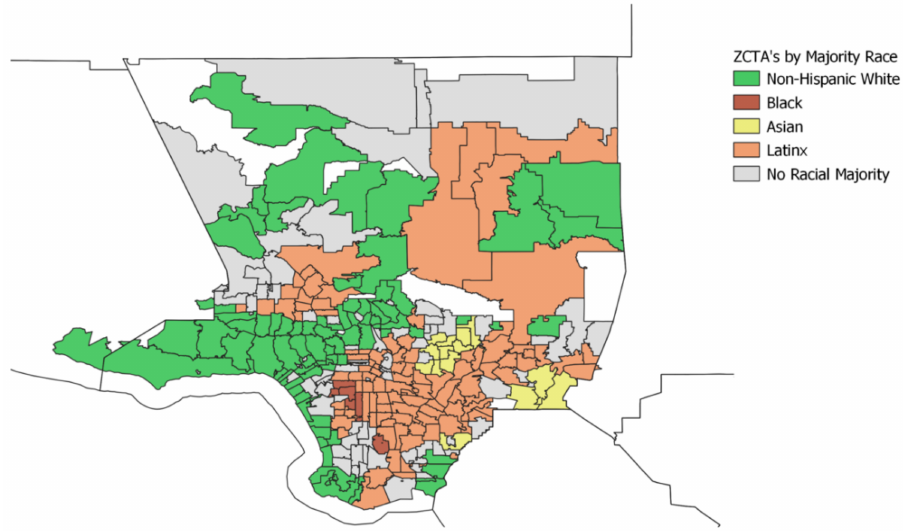
Figure 10. ZCTAs in Los Angeles County by Majority Ethnoracial Group. Figure 10 identifies the majority ethnoracial group in each zip code tabulation area (ZCTA) as determined by the Bureau of